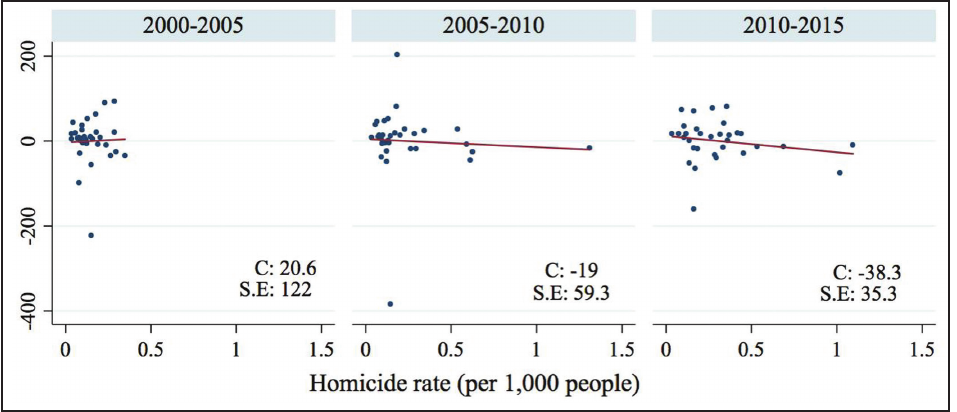
Figure 4 Net migration (in thousands) and homicide rates in Mexican states by period.